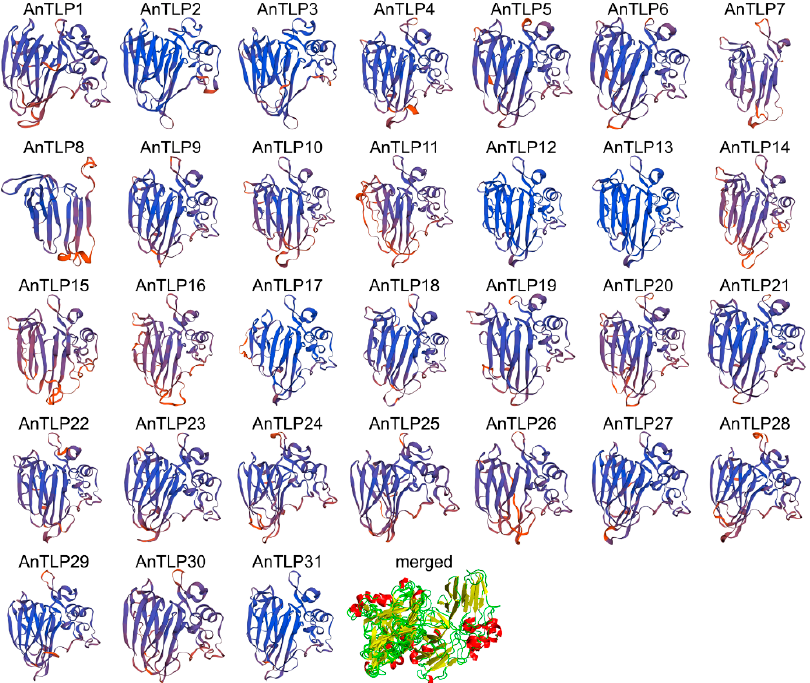
Figure 4. Predicted three-dimensional structures of AnTLPs. The three-dimensional structure prediction was performed in the SWISS-MODEL database. Multiple protein models were combined using PyMol software.